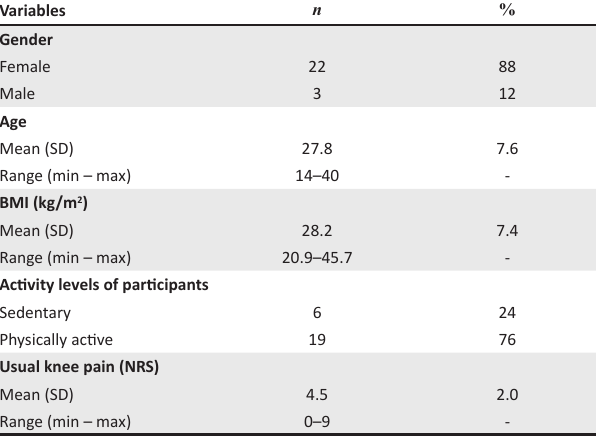
TABLE 1: Sample description for included participants ( n = 25). Variables